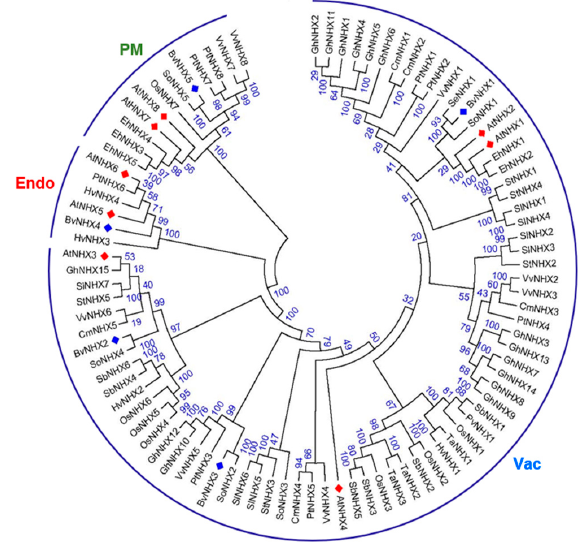
Figure 1. Phylogenetic tree of the NHX genes from Beta vulgaris ( Bv ), Arabidopsis thaliana ( At